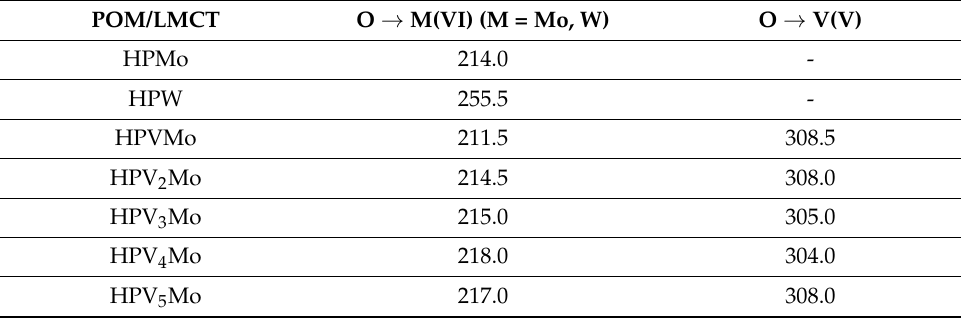
Table 5. Peak positions of the LMCT determined for the molybdates and